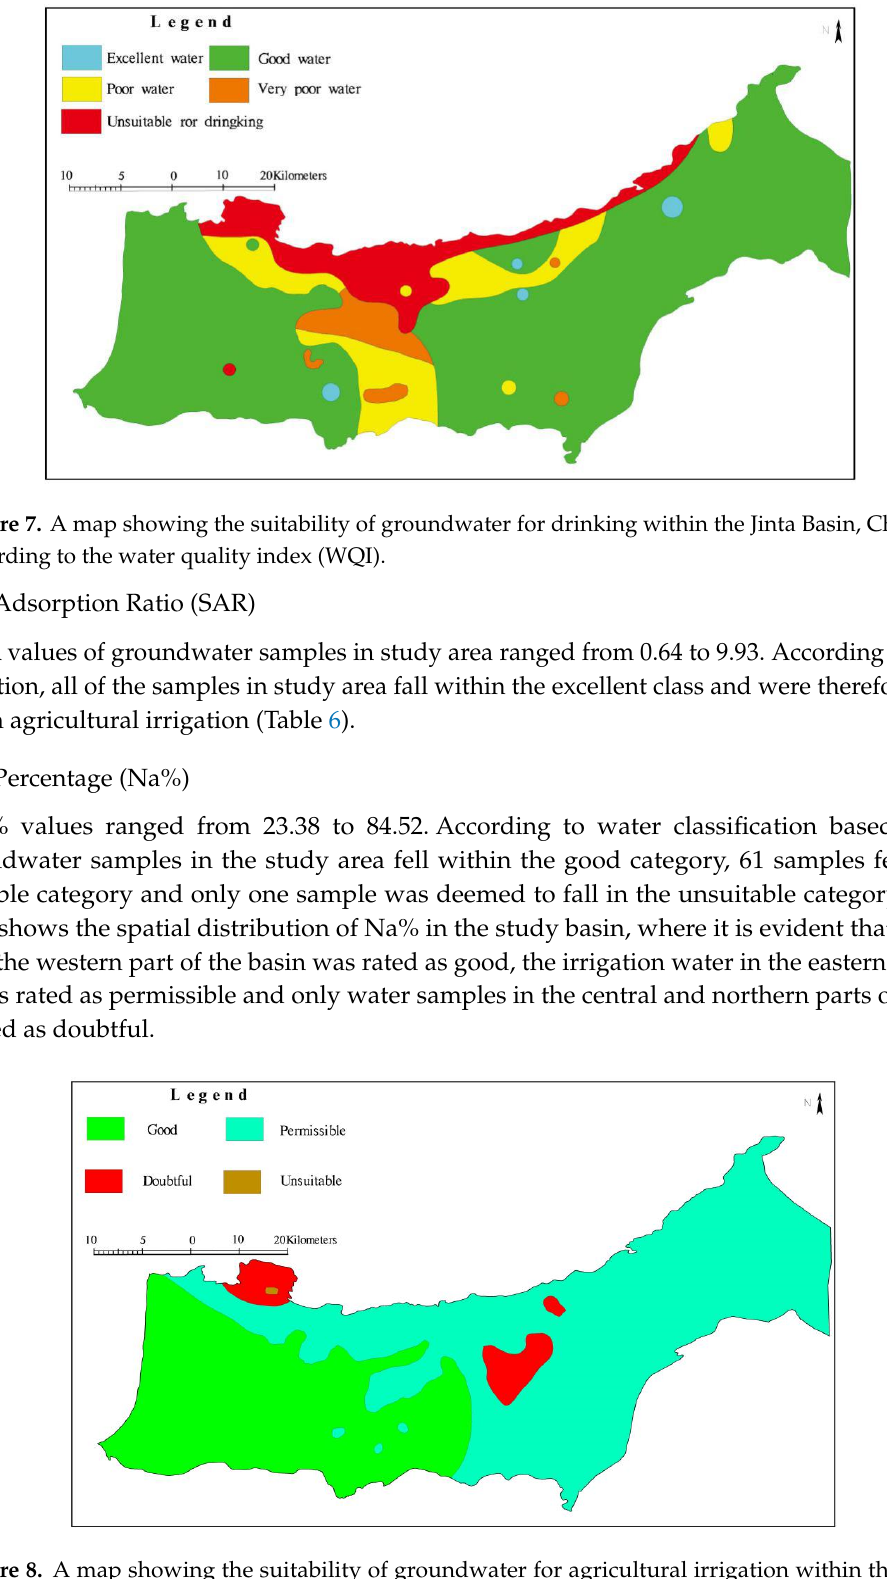
Figure 8. A map showing the suitability of groundwater for agricultural irrigation within the Jinta Basin, China as according to the sodium percentage